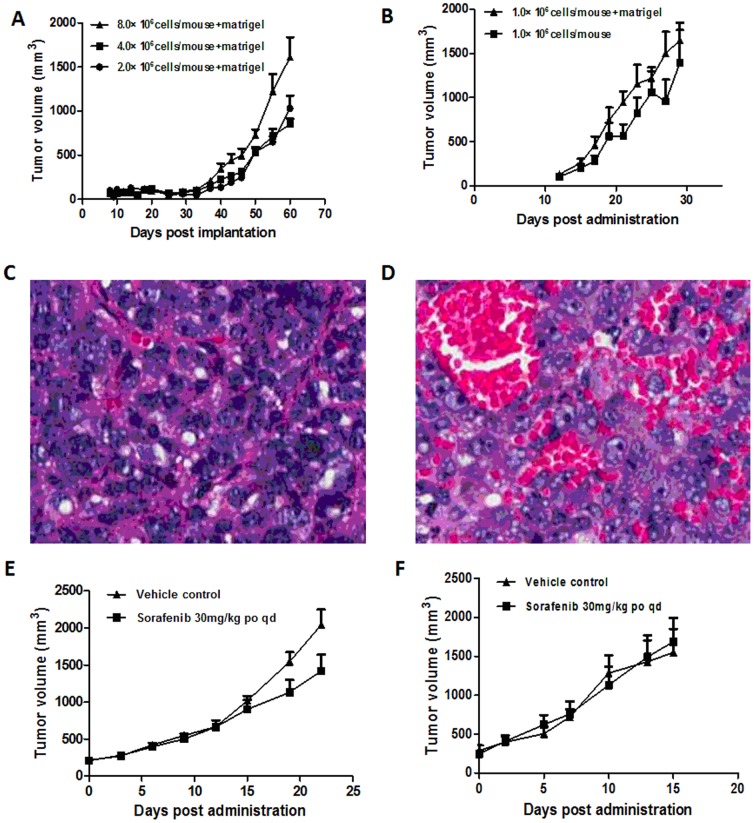
Tumor growth curve of LIXC006 and LIXC012 in tumorigenicity test, H&E staining of xenograft tumors and anti-tumor efficacy of sorafenib.Tumor volume was monitored twice a week. A, tumor growth curve of LIXC006 cells; B, tumor growth curve of LIXC012 cells. C, tumor tissue of LIXC006 cell, tumor cells were crowded together; D, tumor tissue of LIXC012, many blood vessels were inside tissue. Magnification, ×200. E, effect of sorafenib on xenograft tumor of LIXC006; F, effect of sorafenib on xenograft tumor of LIXC012. Data were presented as the mean ± SEM. n = 10.